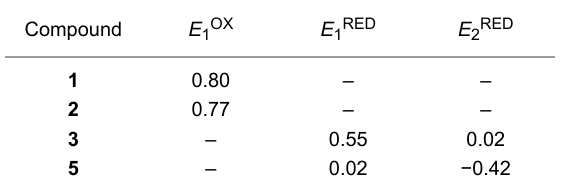
Table 1: CV (cyclic voltammetry) data of TEMPO ( 1 ), AZADO ( 2 ), TCNQF